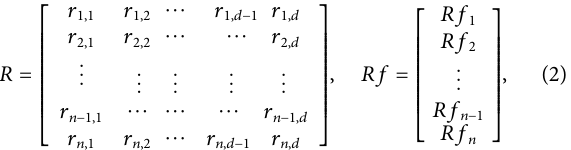
decides the moth movement with respect to fl ames. A conceptual model is drawn in Figure 1 for the moth location updates according to the fl ame. The vertical axis indicates the position of a moth in one dimension, and the horizontal axis presents the possible position update for the next location. The dashed black lines display the locations that can be used for the next position of the moth in the green horizontal line concerning the orange horizontal line of a fl ame. The exploitation and exploration processes can be determined in the search space. Moth uses one dimension to explore and exploit the search space of fl ame. Exploitation emerges if the next position between the moth and fl ame is inside the search space, as directed by arrow 2. In contrast, exploration appears if the position updates between the moth and fl ame are outside the space, as indicated by arrow 1, 3 – 5 in Figure 1. Exploration and exploitation can be observed by following three rules.